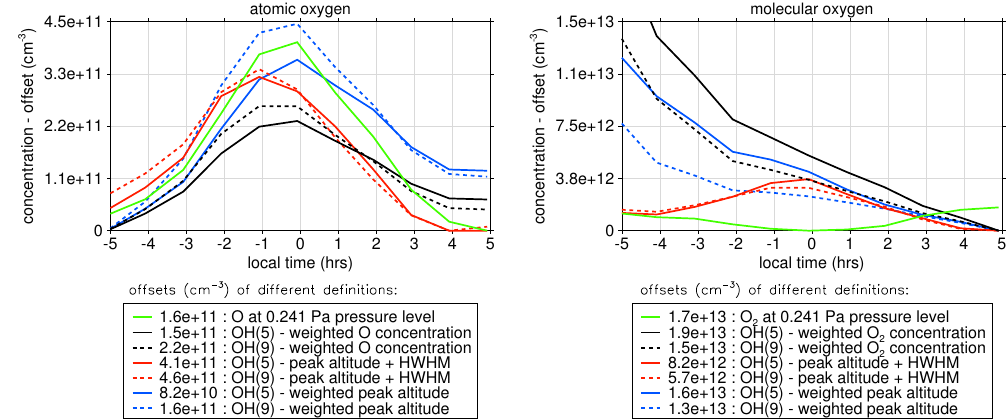
Figure 6. Diurnal variability of simulated atomic and molecular oxygen concentrations. The same denotations apply that are used for the seasonal variability of both species in Fig. 3. The temporal averaging interval ranges from 15 September 2010 to 15 November 2010 to match the same period in our simulations that is needed for one complete SABER yaw cycle.